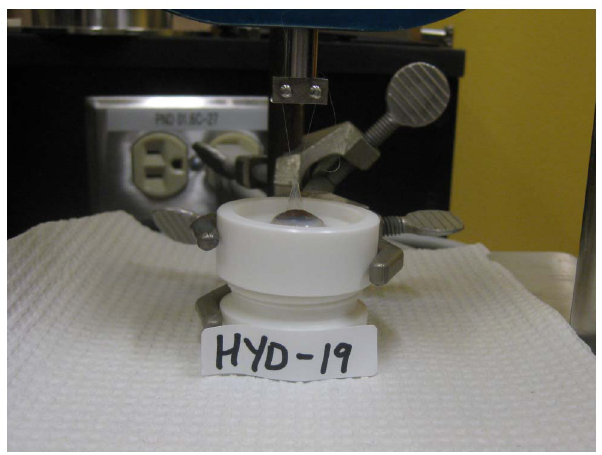
Figure 2. Flap separability testing. The flap was attached to the mechanical tester and lifted until the hinge was reached. Flap separability was assessed by measuring the mean tensile force generated to separate the flap from the posterior part of the